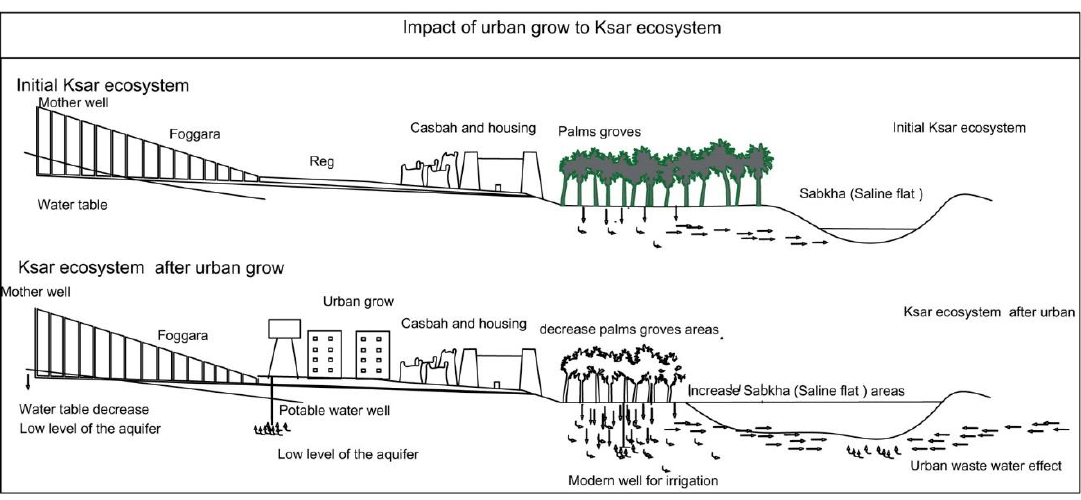
Figure 12 Diagrammatic sectional illustration of negative impact of urban growth to ksar